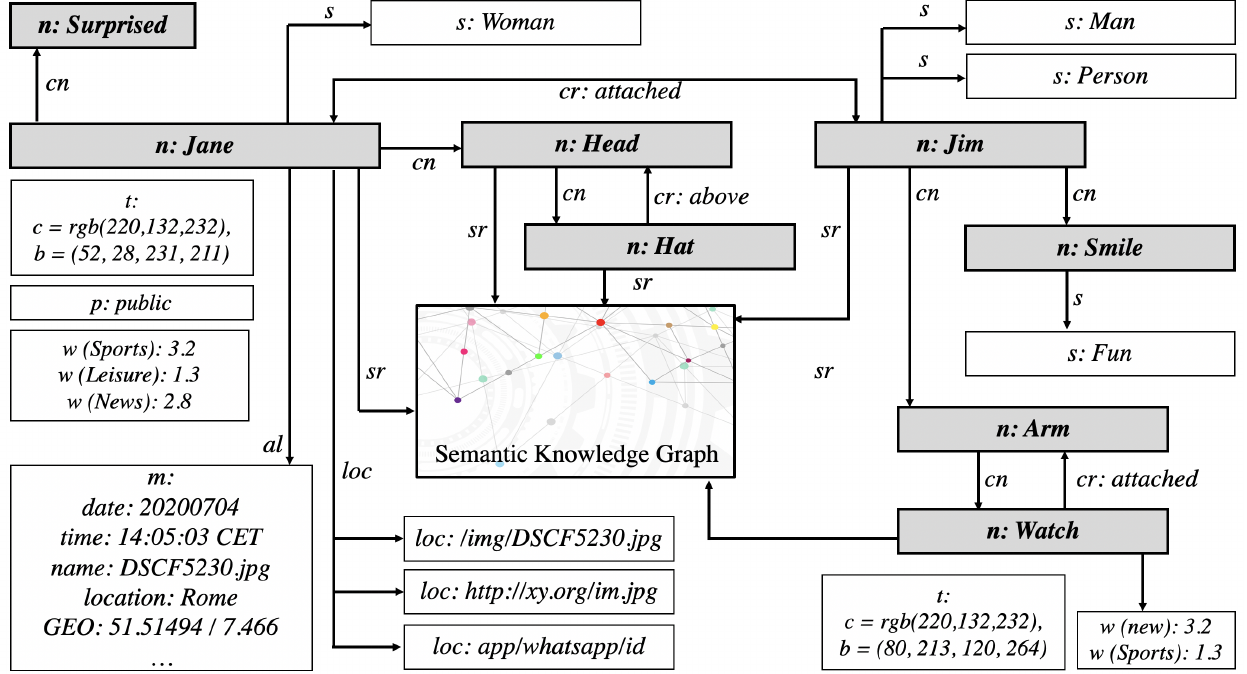
Figure 5. Exemplary multimedia feature vector graph (MMFVG) of an instance with